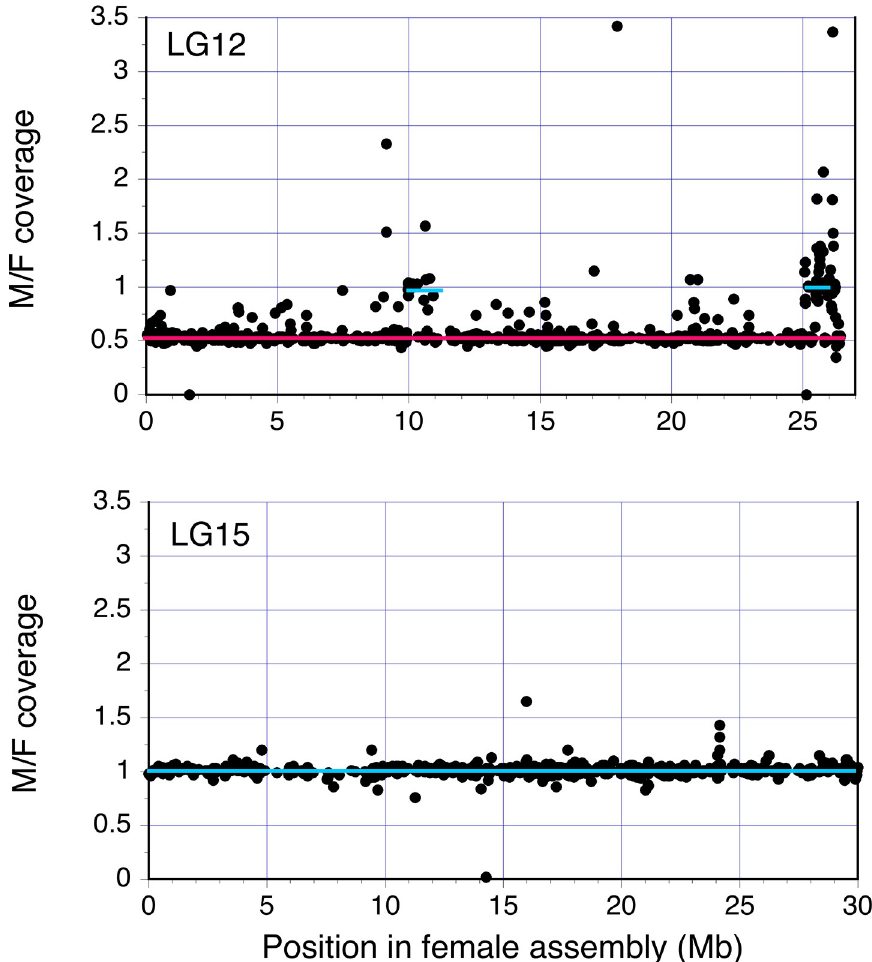
Fig 2. Coverage depths of genes on the M . picta sex chromosome and an autosome. In each part, the y axis shows estimated normalized coverage values and the x axis shows physical positions in the guppy reference assembly of the homologous chromosome. In both the guppy and M . picta , chromosome 12 is the sex chromosome, and LG15 is shown as a representative autosome (as explained in the text, other autosomes are similar). The red horizontal line indicates a value of 0.5, as expected for hemizygous genes, and the blue one indicates diploid coverage (a value of 1), as seen for most genes across the autosome, and for two clusters of LG12 genes.